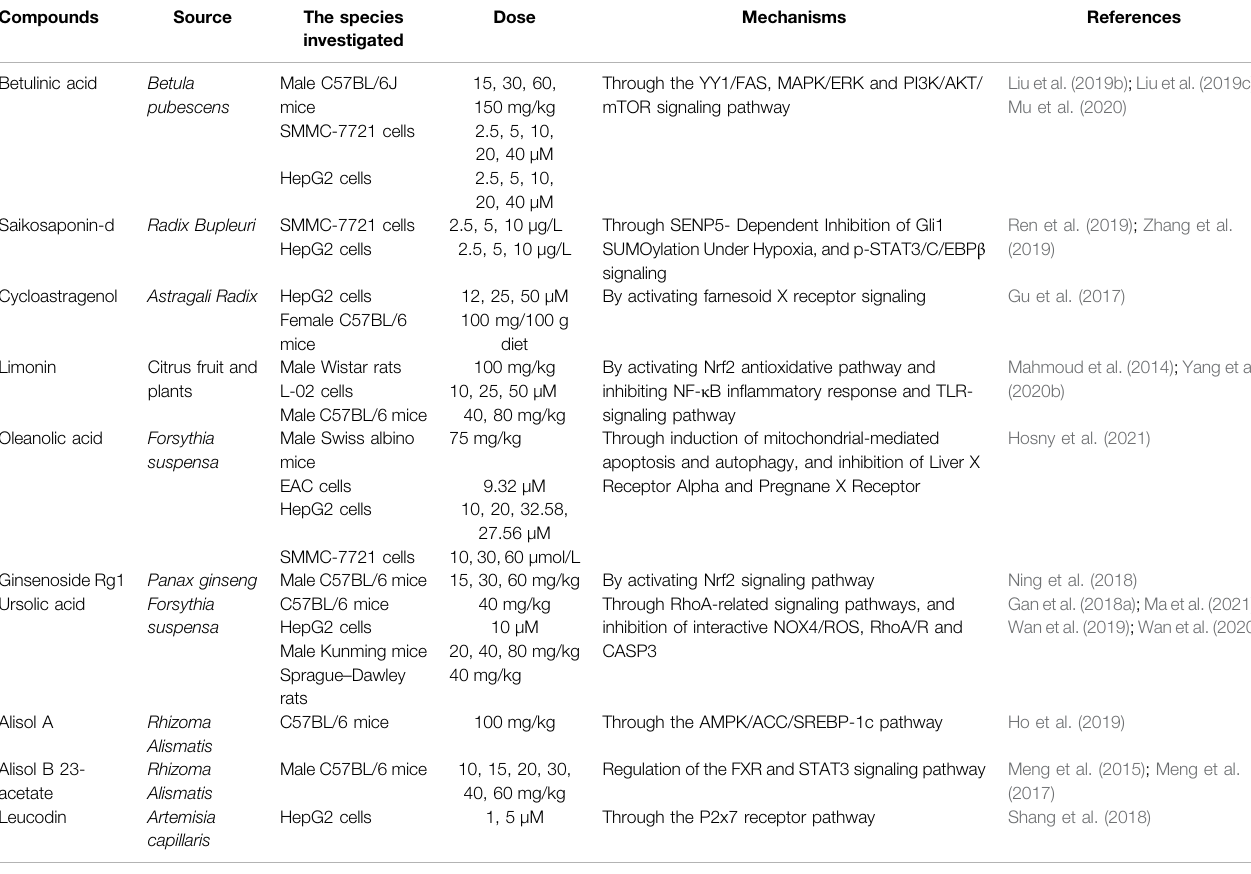
TABLE 4 | Summary of terpenoids with signi fi cant anti-liver disease activity.